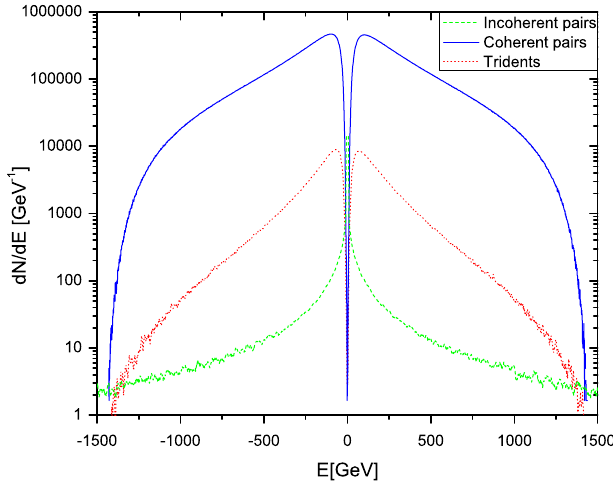
FIG. 9. Spectrum of the various pair production mechanisms after full beam crossing simulation.